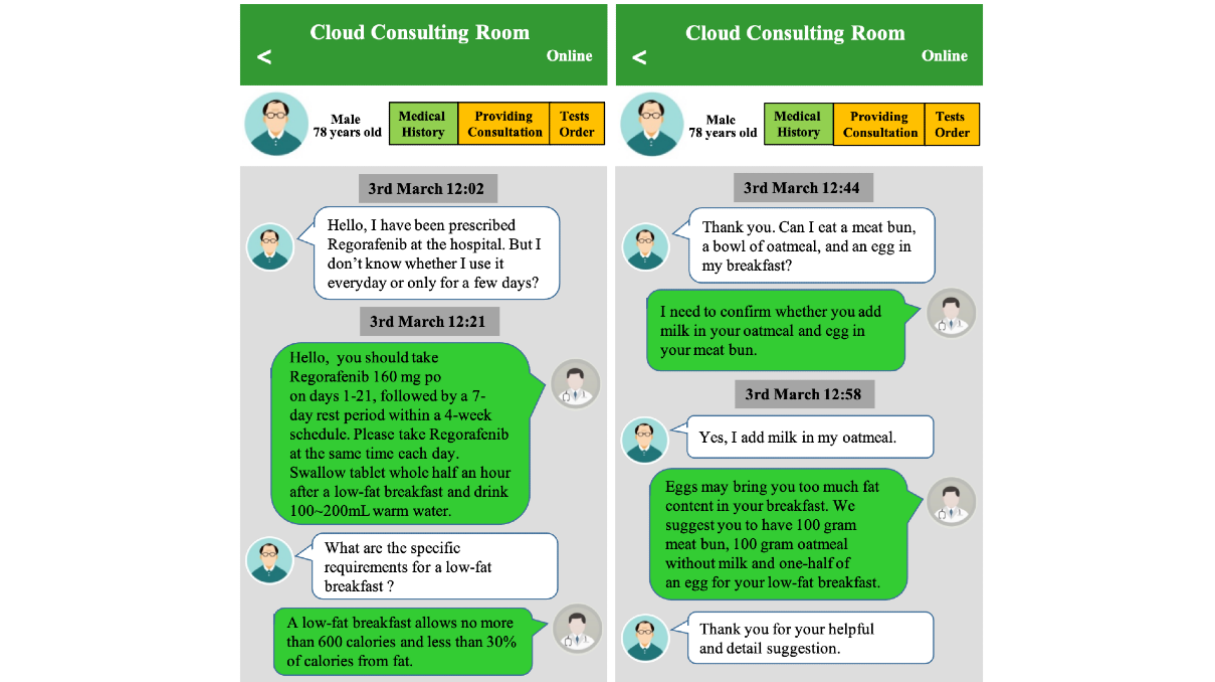
Figure 1. Screenshot of real-time medication consultation between clinical pharmacists and